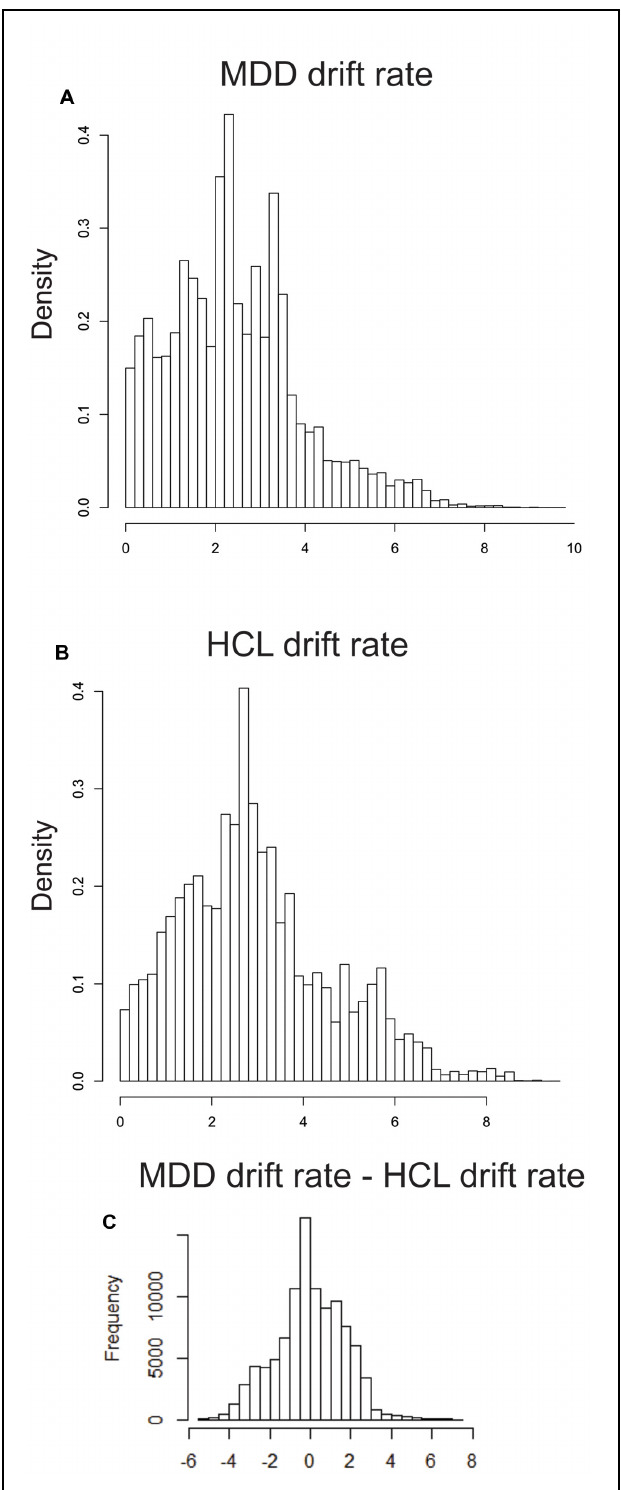
FIGURE 3 | Group differences in posterior estimates of drift rate. We used the mean ( μ ) and variability ( σ ) hyper distributions for drift rate on correct trials ( v c ) to calculate the mean of the associated truncated normal distribution for MDD (A) and (B) HCL. (C) Differences in these means (MDD – HCL). See LBA Parameter Estimation in the Methods for more